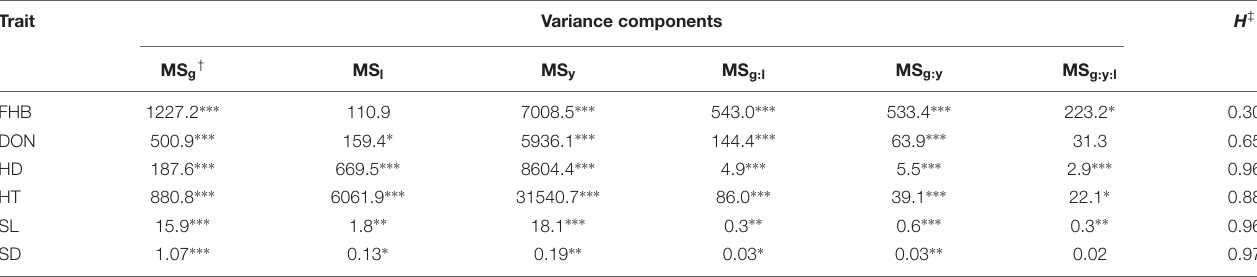
TABLE 2 | ANOVA analyses across environments and heritability estimation on a progeny mean basis in the Rasmusson/PI 383933 recombinant inbred line (RIL) population for Fusarium head blight (FHB), deoxynivalenol accumulation (DON), heading date (HD), plant height (HT), spike length (SL), and spike density (SD). Trait Variance components